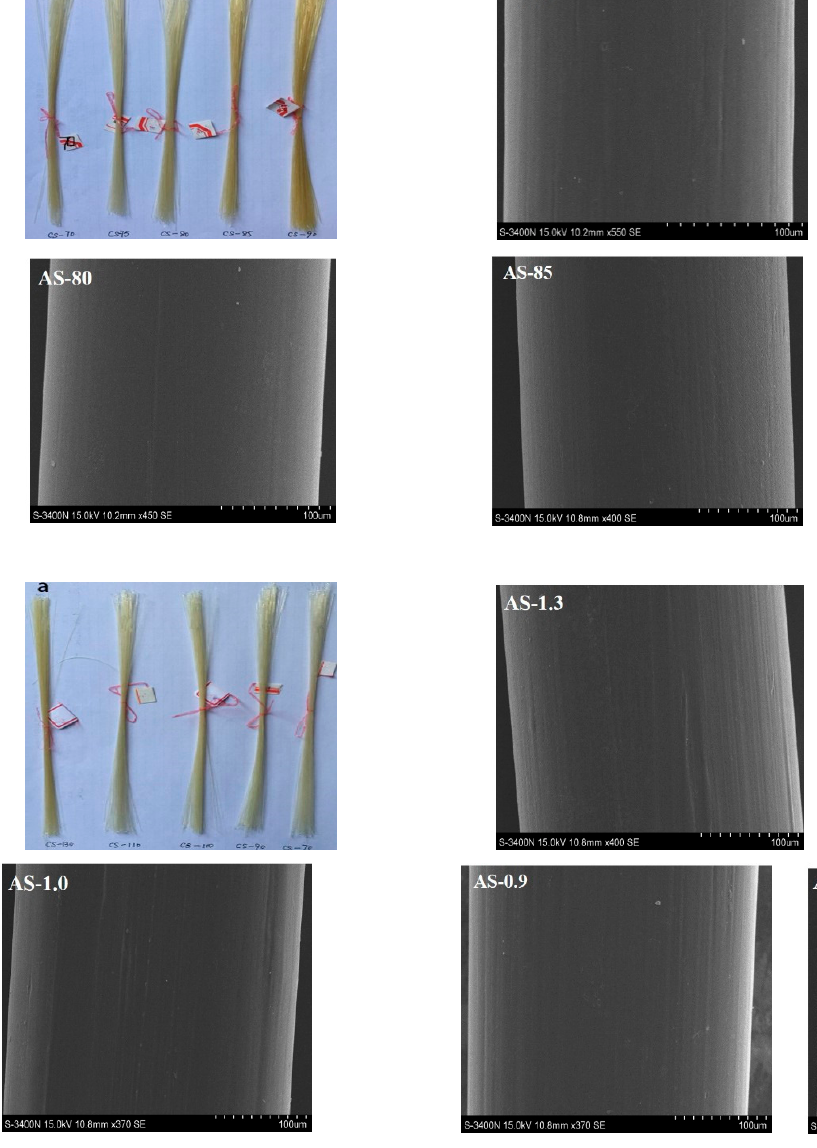
Figure 1. Appearance picture and surface SEM images of chitosan monofilaments with different DD ( A ) and chitosan monofilaments with different M V ( B ).